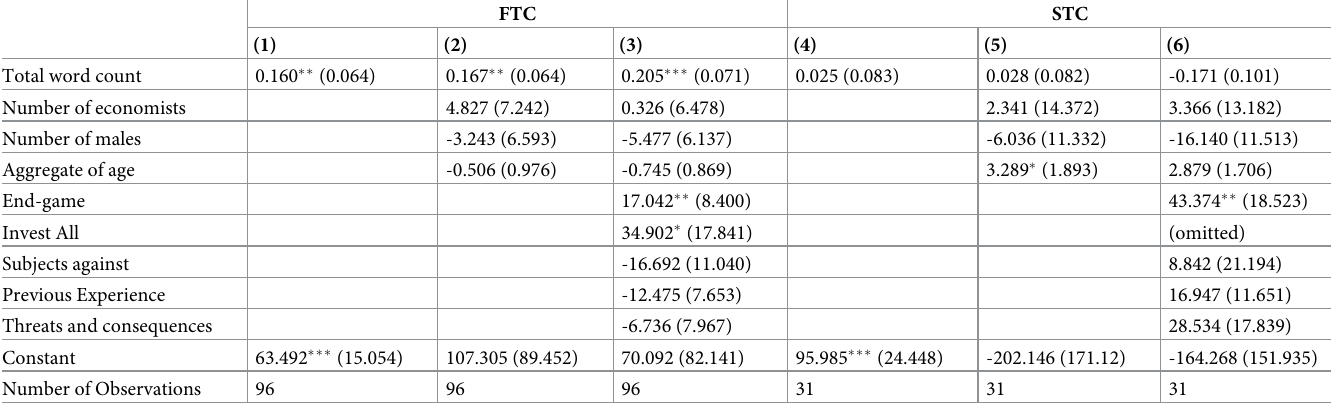
Table 8. Tobit regressions of contributions on group level for FTC and